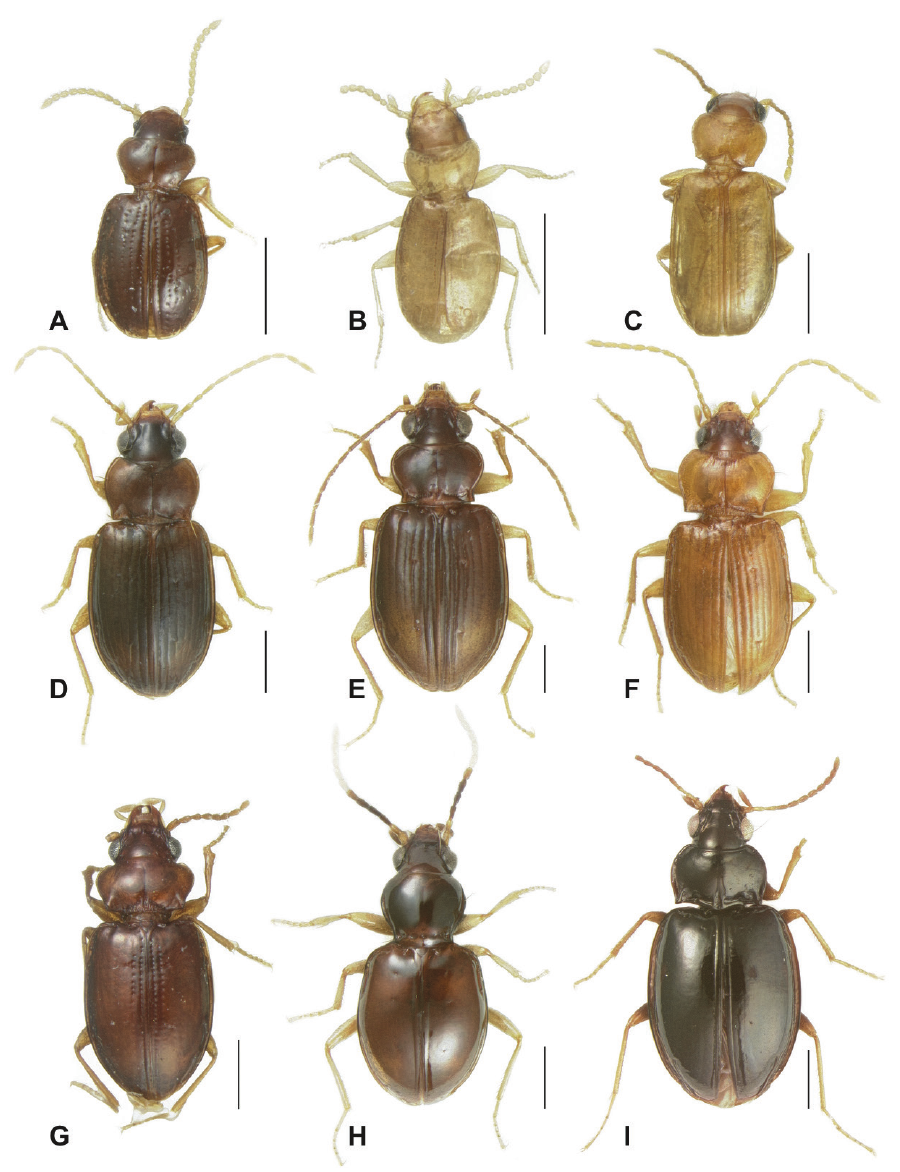
Figure 2. New Tachyina. A Stigmatachys uvea (holotype, ♀ ), Perú, Loreto, Campamento San Jacin- to B Polyderidius sp., México, San Luis Potosí; C Nothoderis rufotestacea , USA, Arizona, Cochise Co. D Meotachys ( Hylotachys ) ballorum (paratype, ♀ ), Brazil, Amazonas, Tapurucuara E Elaphropus ( Am- motachys ) marchantarius (paratype, ♂ ), Venezuela, San Carlos de Rio Negro F Meotachys ( Scolistichus ) riparius (paratype, ♀ ), Brazil, Amazonas, Rio Solimões, Ilha de Marchantaria; G Elaphropus ( Idiotachys ) acutifrons (holotype, ♀ ), Brazil, Santarem H Elaphropus ( Nototachys ) occidentalis (paratype, ♂ ), Perú, Madre de Dios, Pakitza I Tachyxysta howdenorum (holotype, ♂ ), México, Chiapas, El Aguacero. Scale bars = 0.5